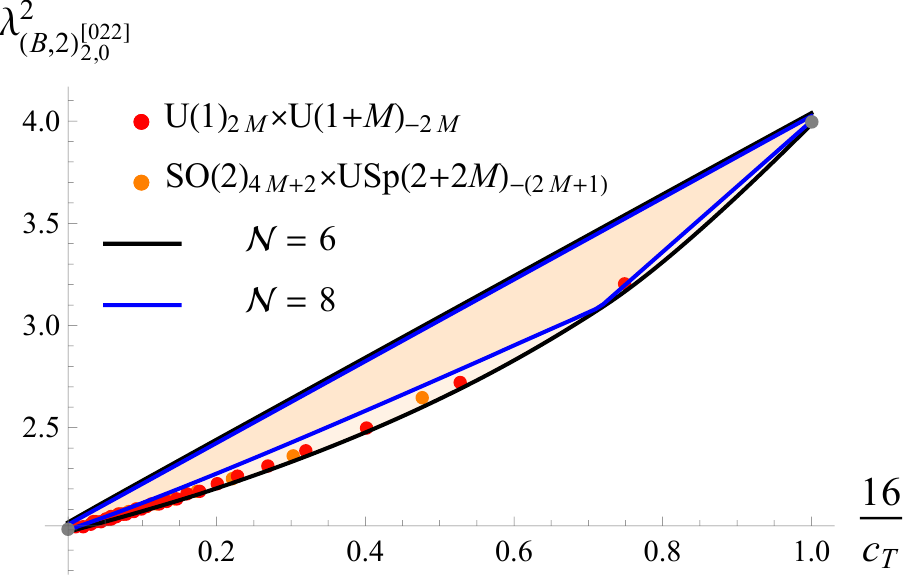
Figure 1 . Upper and lower bounds on the λ 2 OPE coefficient in terms of the stress-tensor co- ( B, 2) [022] 2 , 0 efficient c T , where the orange shaded region is allowed, and the plot ranges from the generalized free field theory (GFFT) limit c T → ∞ to the free theory c T = 16 . The black lines denote the N = 6 up- per/lower bounds computed in this work with Λ = 39 , the blue lines denotes the N = 8 upper/lower bounds computed in [10] with Λ = 43 . The red and orange dots denote the exact values in tables 7 and 11 for the U(1) 2 M × U(1+ M ) − 2 M and SO(2) 4 M +2 × USp(2+2 M ) theories, − (2 M +1)